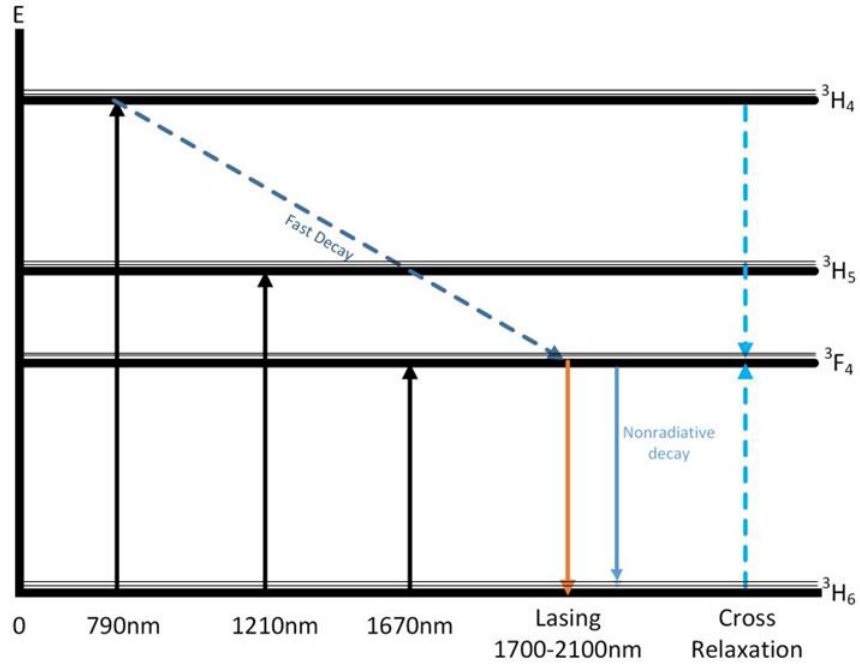
Figure 1. Energy Levels of Thulium.